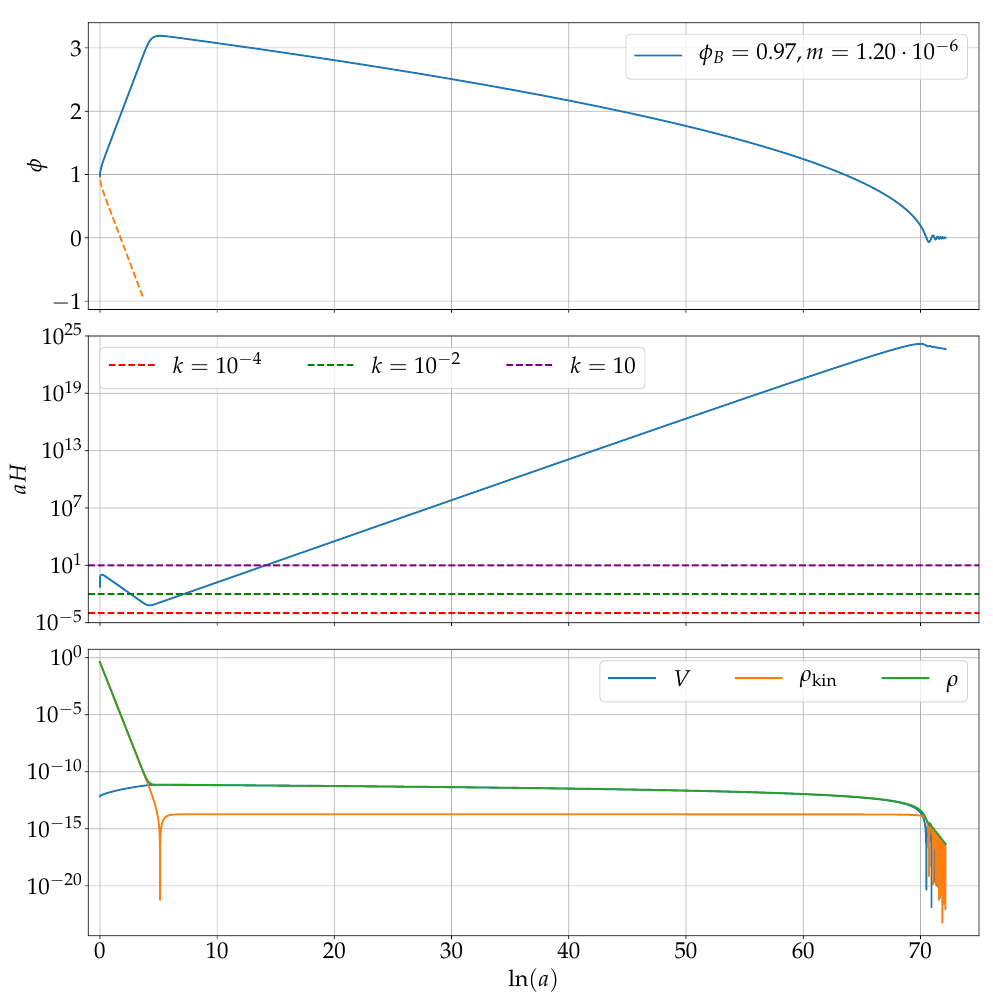
Figure 1. Solution for m = 1.2 10 − 6 and φ B = 0.97. The upper panel shows the evolution of the × inflaton, the middle panel that of the rescaled Hubble parameter aH , and the lower pannel that of the energy density, with its kinetic and potential contributions. In the case of aH , we have plotted also several wavenumbers to illustrate different scenarios for horizon